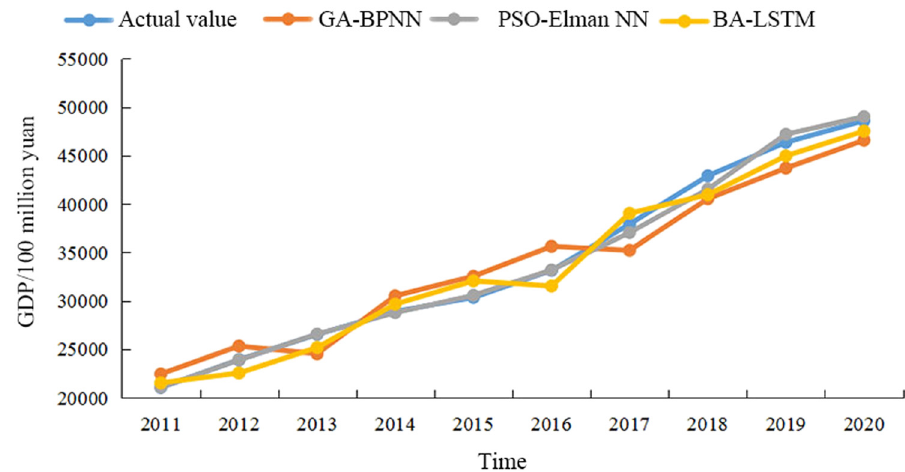
Figure 1: GDP prediction results of di ff erent